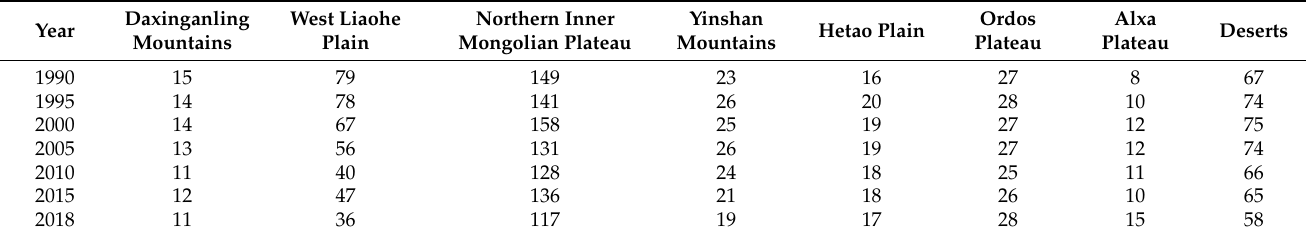
Table 3. Number of lakes with individual areas of >1 km 2 in the different geomorphological units.